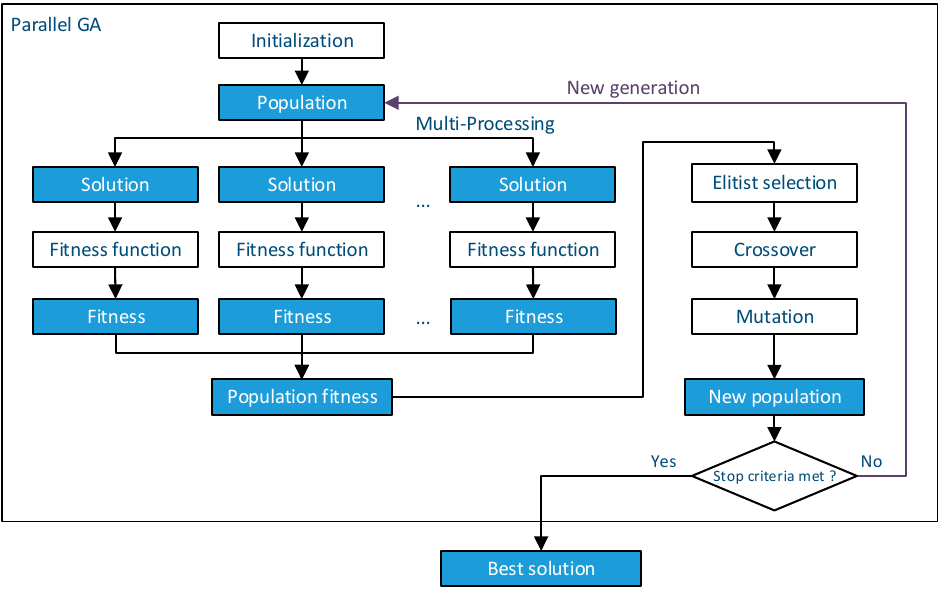
Figure 2. Workflow of parallel GA.